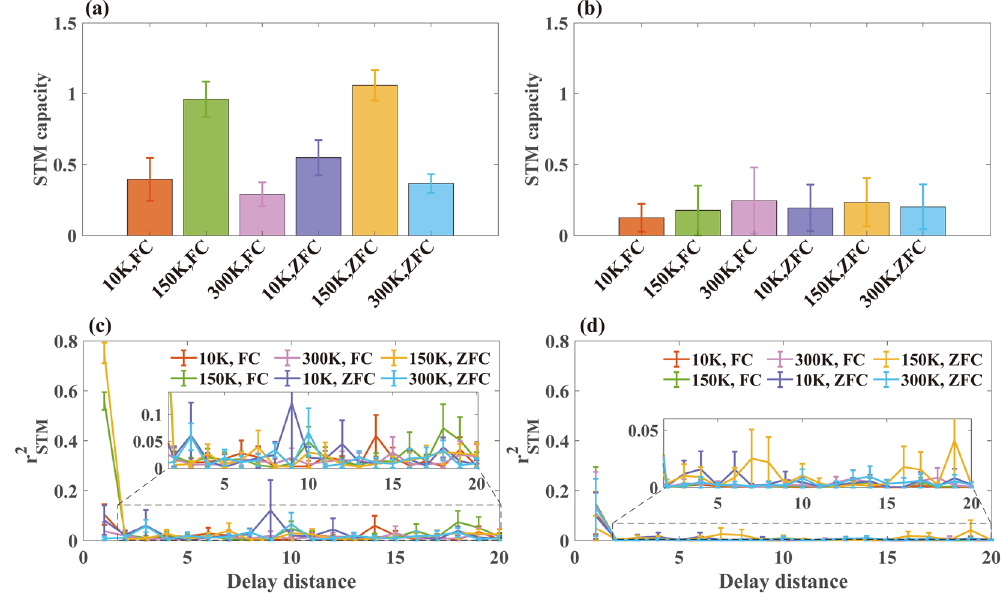
Figure 5. Short-term memory capacities of ( a ) LFCS and ( b ) LuIG under different temperature and cooling 2 schemes. r STM ( d ) of ( c ) LFCS and (d) LuIG under different temperature and cooling schemes. The input binary sequence is mapped from {0, 1} to {0, 100